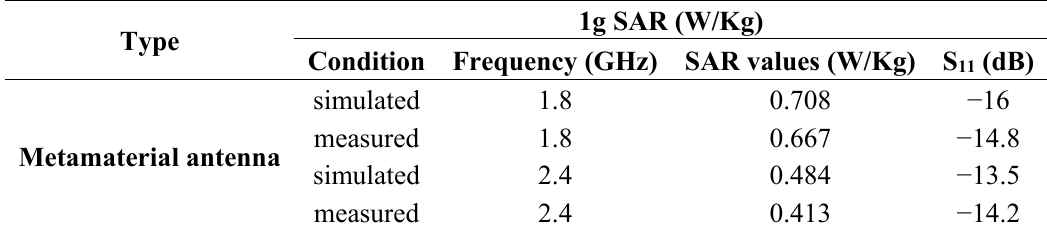
Figure 10. 1 g SAR measurements of the proposed antenna at ( a ) 1.8 GHz and ( b ) 2.4 GHz. Table 2. SAR values of the proposed